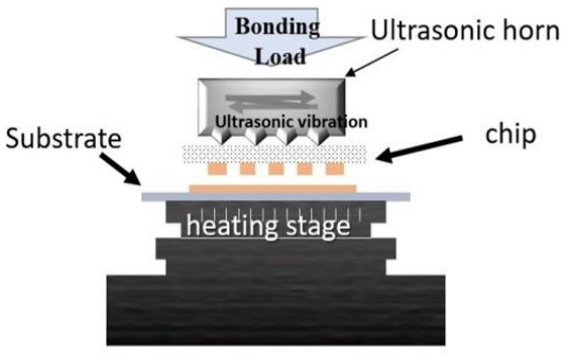
Figure 5. Schematic of the ultrasonic bonding machine.